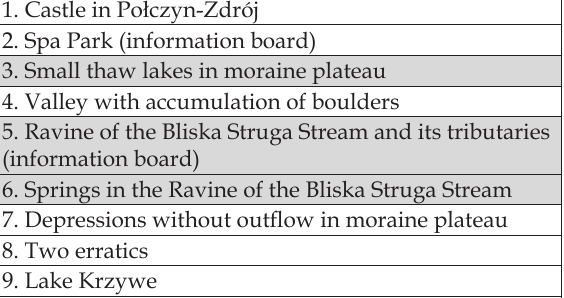
Fig. 2. the “Połczyn Switzerland” geotourist path with marked geosites acc. kamieńska, Giemza (2013). the boundaries of the planned geopark “Postglacial land of the Drawa and Dębnica rivers” as well as boundaries of the Drawski Landscape Park are marked in the map. Table 2. Geosites (described in this paper, marked in grey) and other places worth seeing along the “Połczyn Switzerland” geotourist